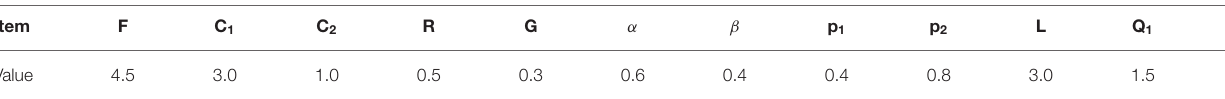
TABLE 4 | The parameter settings of scenario 1.